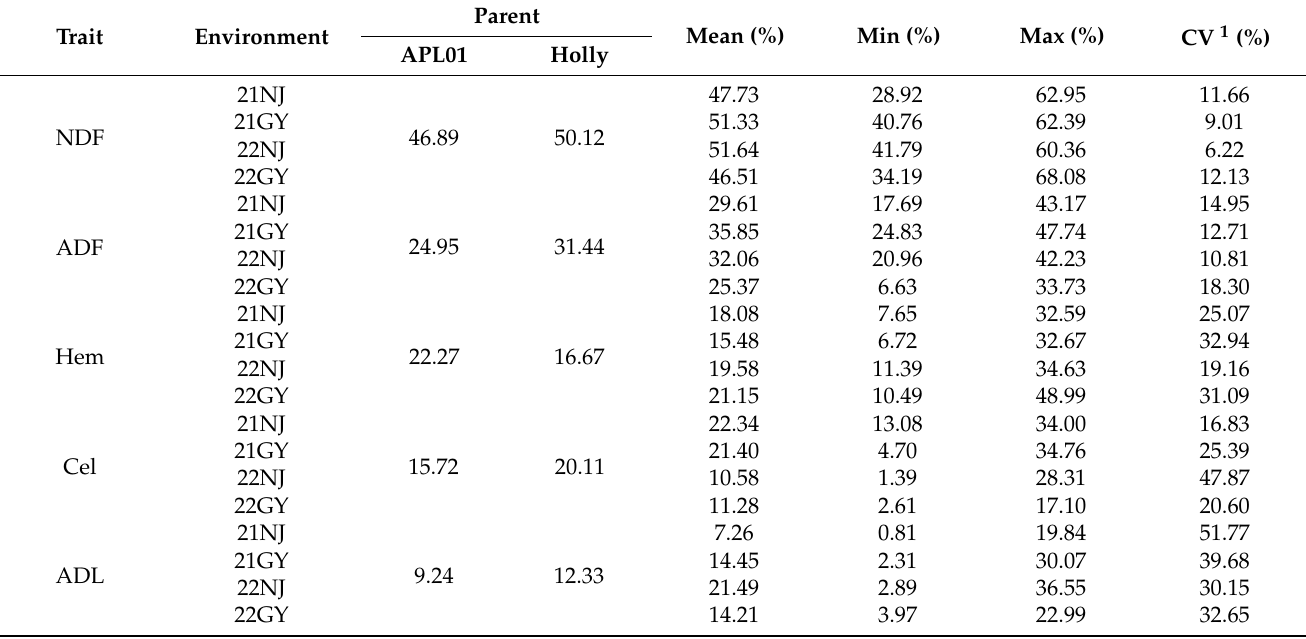
Table 1. Statistical analysis of crude fiber component in B. napus